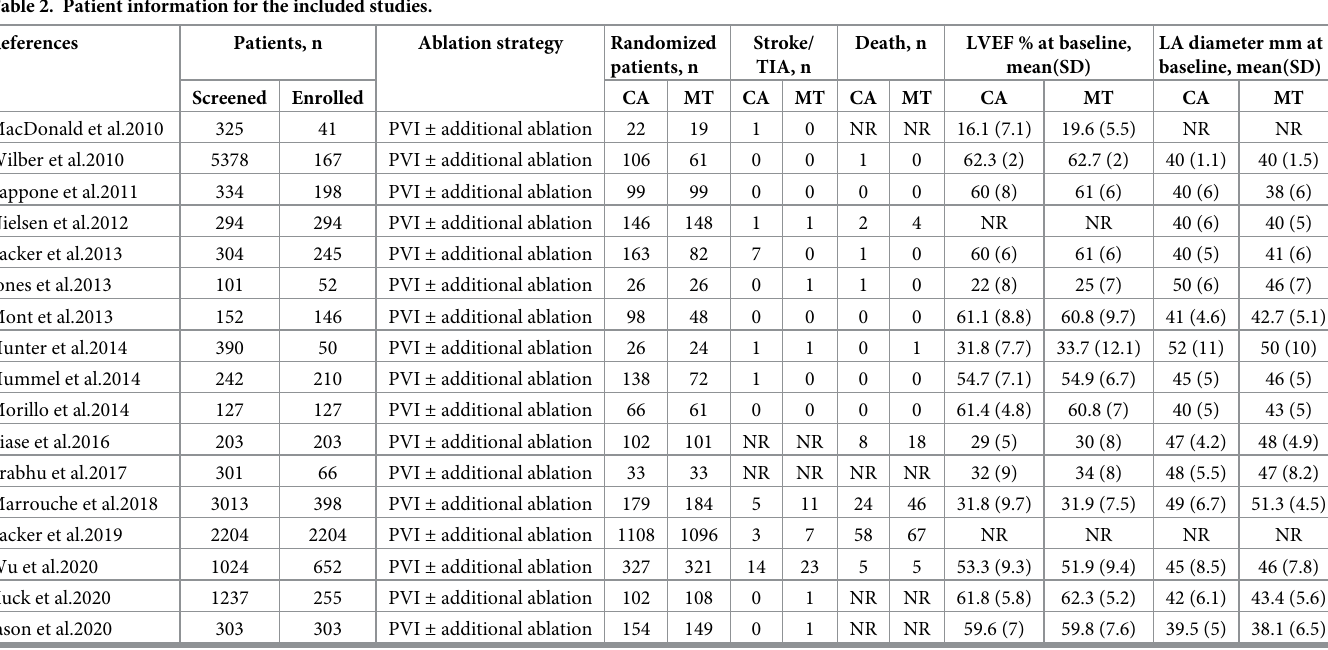
Table 2. Patient information for the included